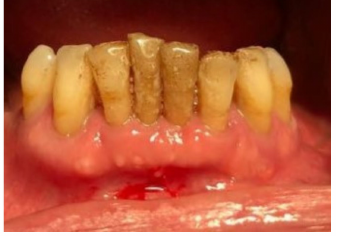
Figure 1. Pre-surgical condition, Group A.